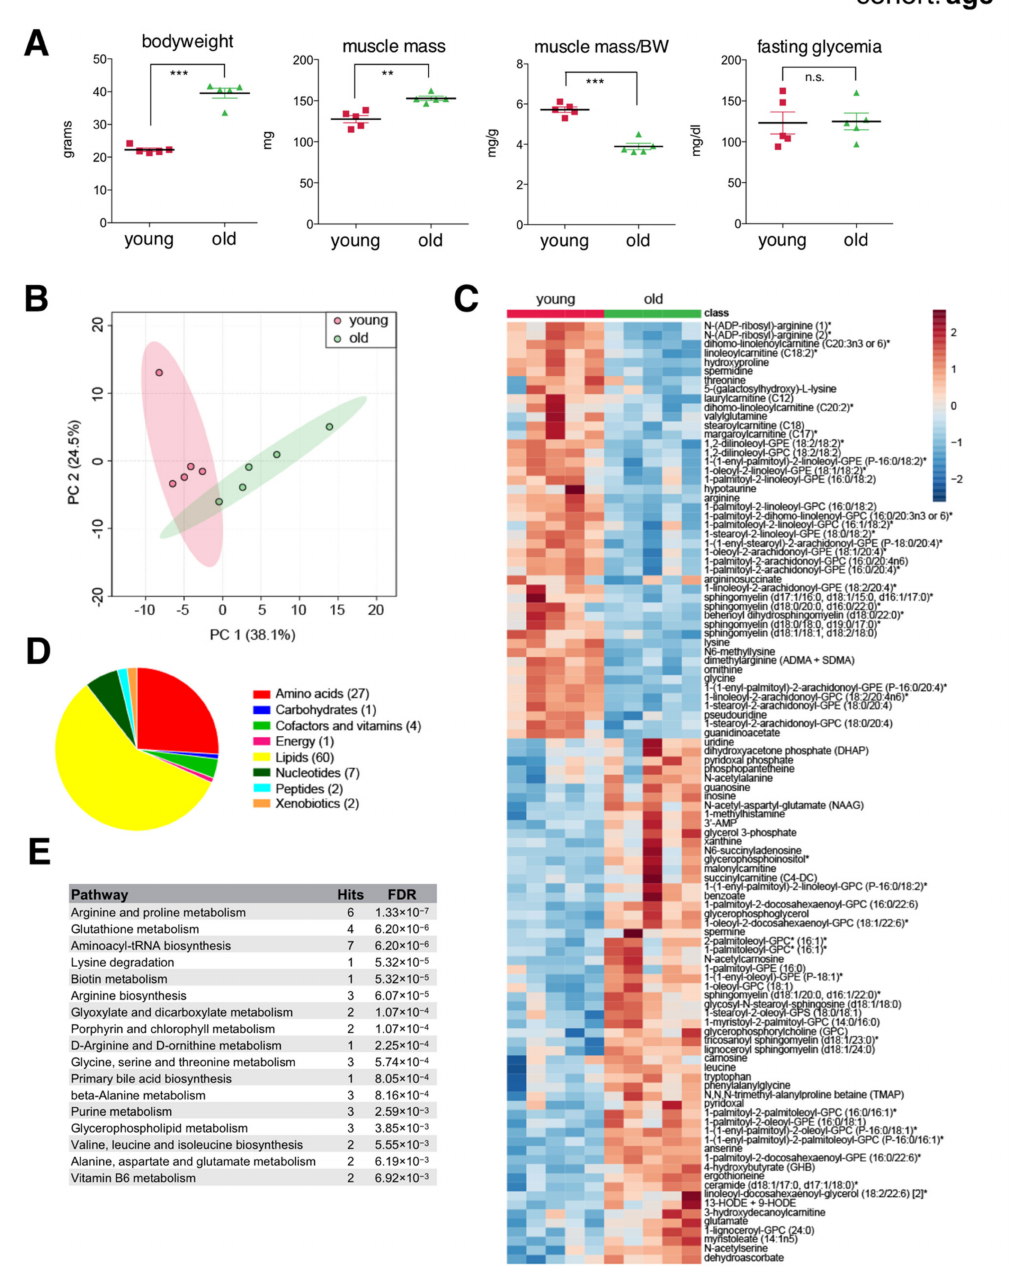
Figure 2. The skeletal muscle metabolome reflects changes associated with age. ( A ) Bodyweight, muscle weight ( gastrocne- mius ), muscle weight relative to bodyweight (BW), and glycemia after a 4 h fast of young (2-month) and old (21-month) male C57BL/6N mice (mean ± SEM; n = 5; *** p < 0.0001, ** p = 0.0011, n.s. not significant, Student’s t -test). ( B ) Principal component analysis of the entire metabolomics data set. ( C ) Heatmap of metabolites selected by random forest shown for individual samples. Metabolites labeled with an asterisk have not been confirmed with a standard, but we are confident of their identity. ( D ) Classification of random forest selected metabolites to their metabolite class. The number of metabolites per class is given in parentheses. ( E ) Quantitative enrichment analysis showing the top enriched pathways with FDR < 0.01 based on the metabolites selected by random